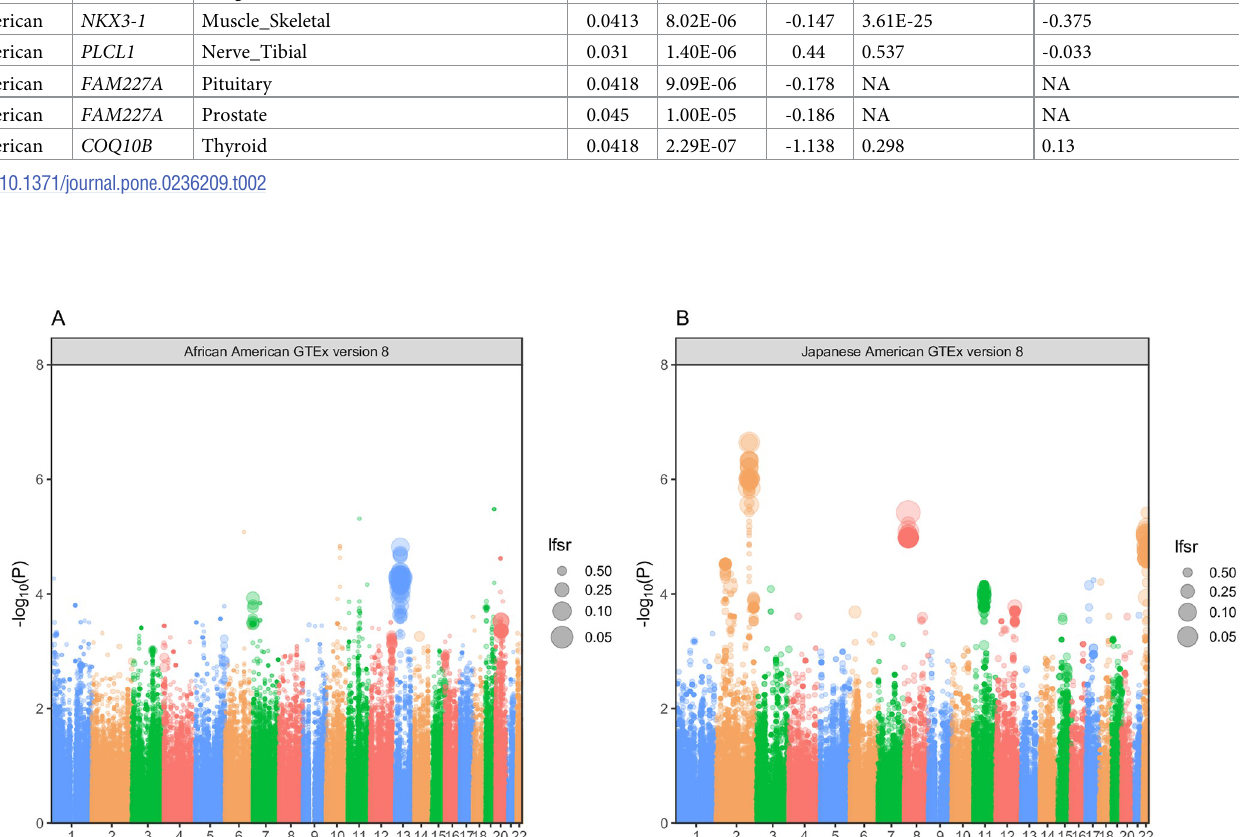
PLOS ONE | https://doi.org/10.1371/journal.pone.0236209 September 28,